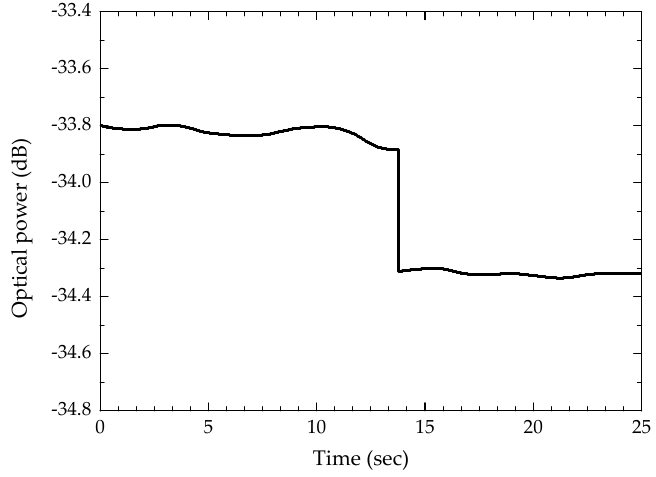
Figure 4. Step technique to estimate the resolution of the sensor.